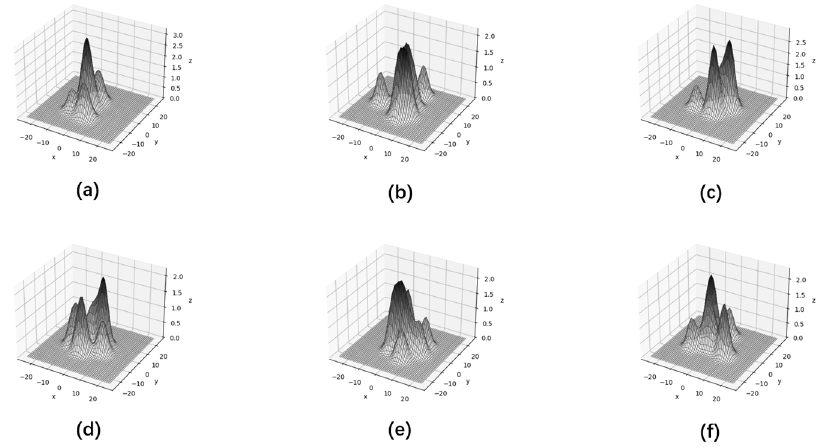
Figure 3. Multi-frame superimposed point target imaging: ( a , f ) present a higher peak and some smaller peaks; ( b , e ) present a situation where the responses are mixed with each other; ( c ) presents two similar peaks; ( d ) presents a broken change model.